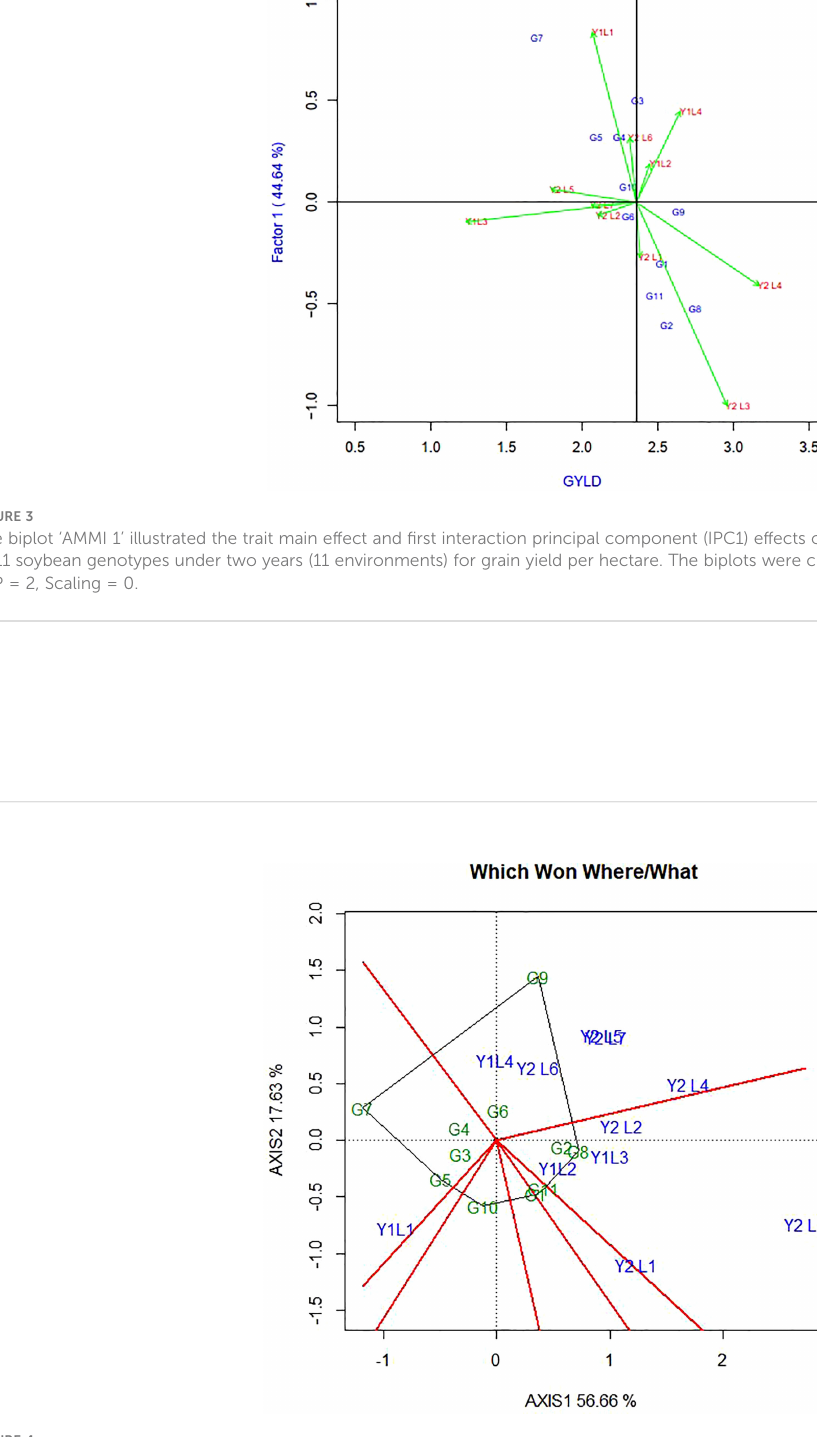
FIGURE 4 ” Which-won where ” pattern of GGE biplot polygon view displaying the genotype main effect plus GEI effect of 11 soybean genotypes under two years (11 environments) for grain yield per hectare. The biplots were based on Centering =0, SVP=2,